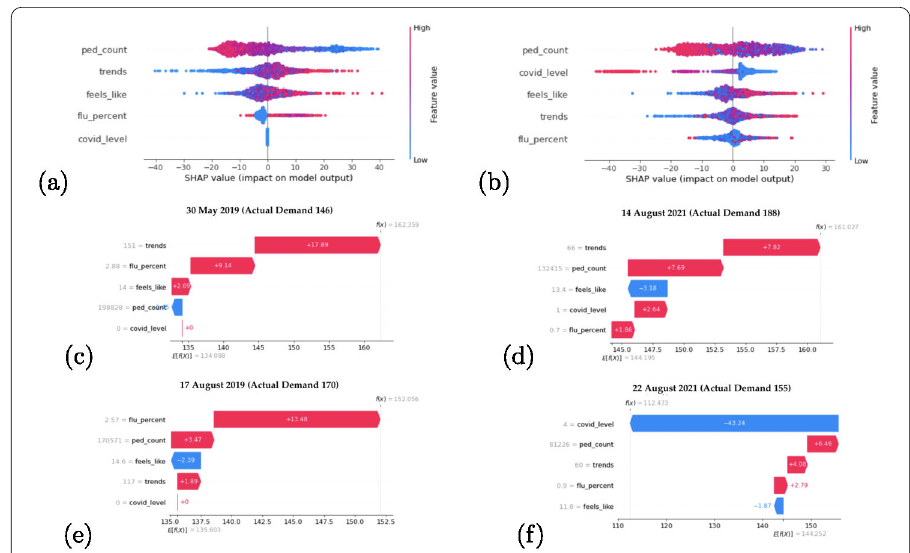
Figure 9 SHAP proxy-only model graphs for 2019 (Left) and 2021 (Right). ( a ) and ( b ) depict feature importance summary plots. ( c )–( f ) show explanations of forecasts for specific dates together with the observed